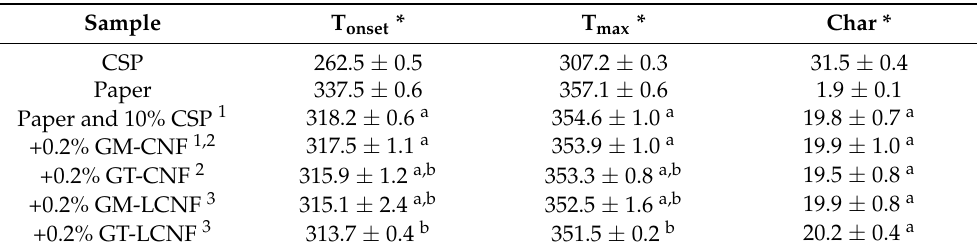
Table 2. Thermal properties of cottonseed protein isolate and paper samples treated with cottonseed protein and cellulose nanofiber